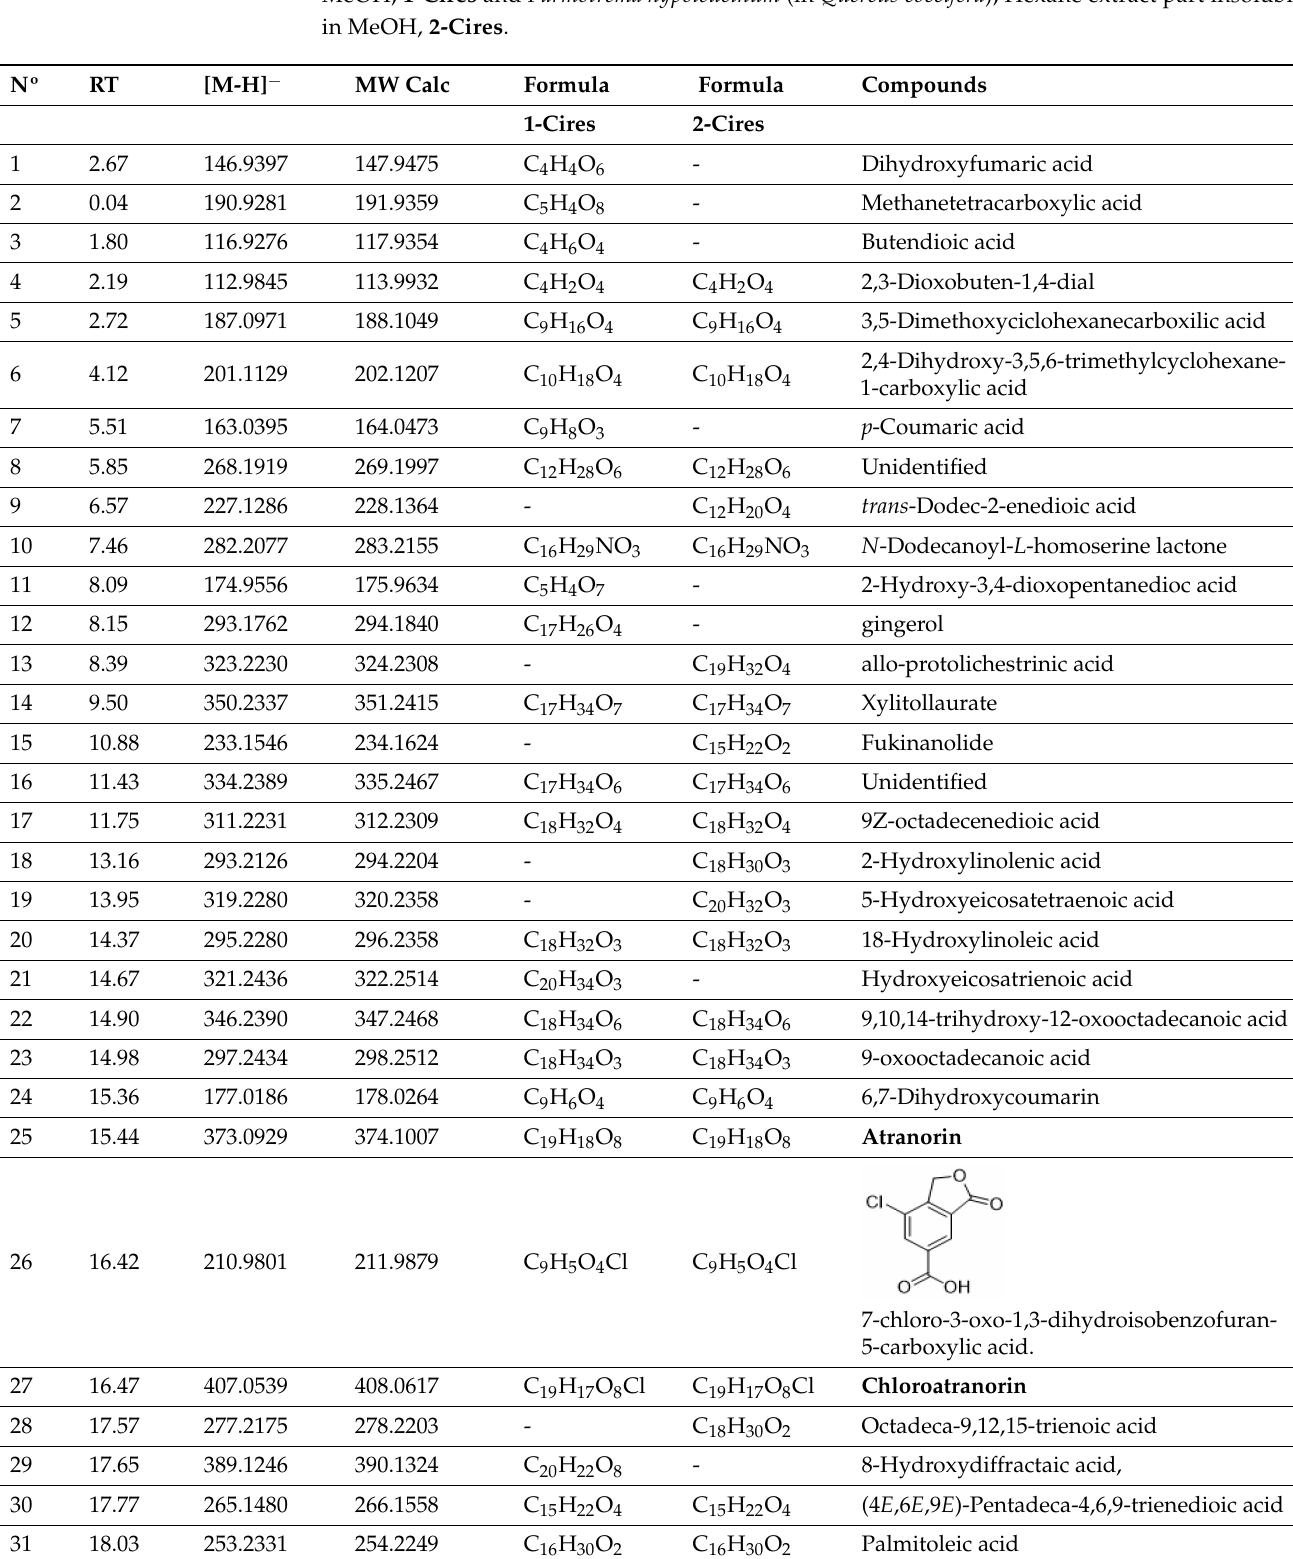
Table 6. Samples Parmotrema hypoleucinum (in Olea europea ), Hexane extract part insoluble